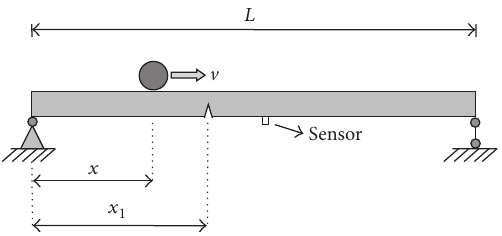
Figure 1: Sketch of the beam model subject to a moving